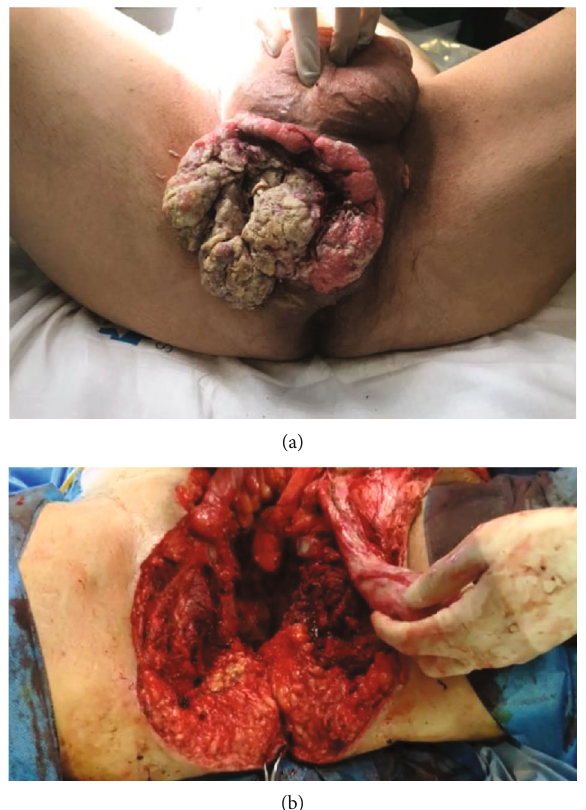
Figure 1: Locally advanced perineal carcinoma. (a) A voluminous and heterogeneous perineal mass. (b) Total penectomy and pelvis exenteration with resection of both ischiopubic